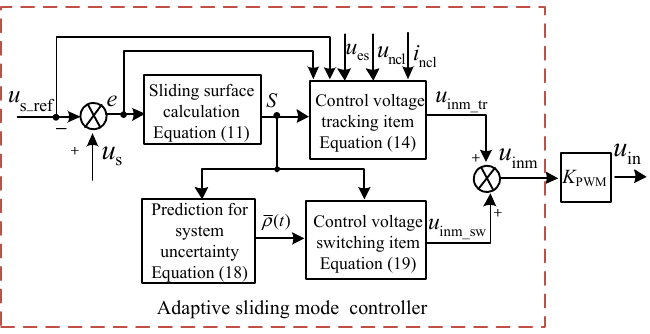
Figure 3. Block diagram of adaptive sliding-mode control applied in this work.